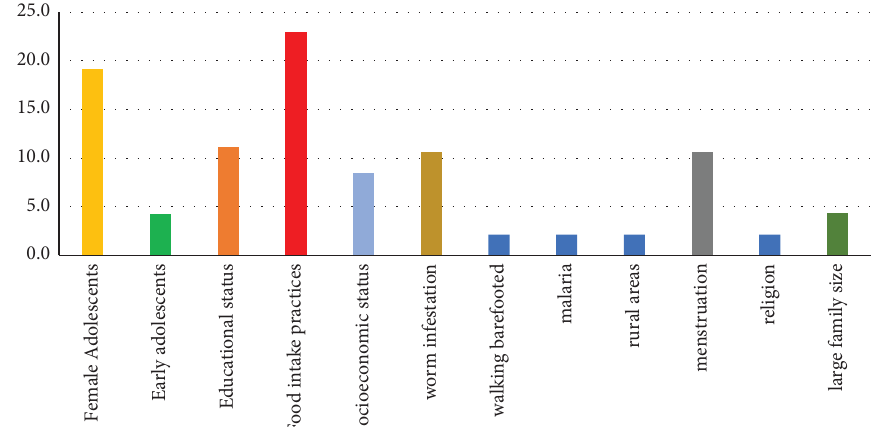
Figure 2: Risk factors of anaemia. Education: low maternal education 1 and adolescent; food intake practices: vegetarian diet 1 , low dietary iron intake, lower meal frequency, lower dietary diversity, meal skipping, and snacking; menstruation: excessive bleeding 1 and menarche. 1 indicates